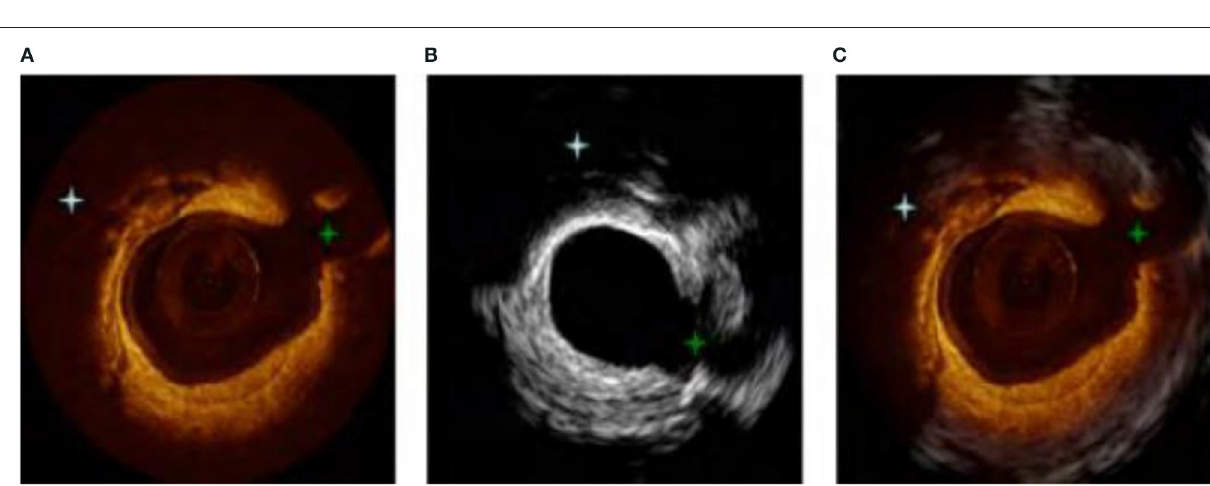
FIGURE 10 | (A–C) Combination image of new intravascular ultrasound technology and